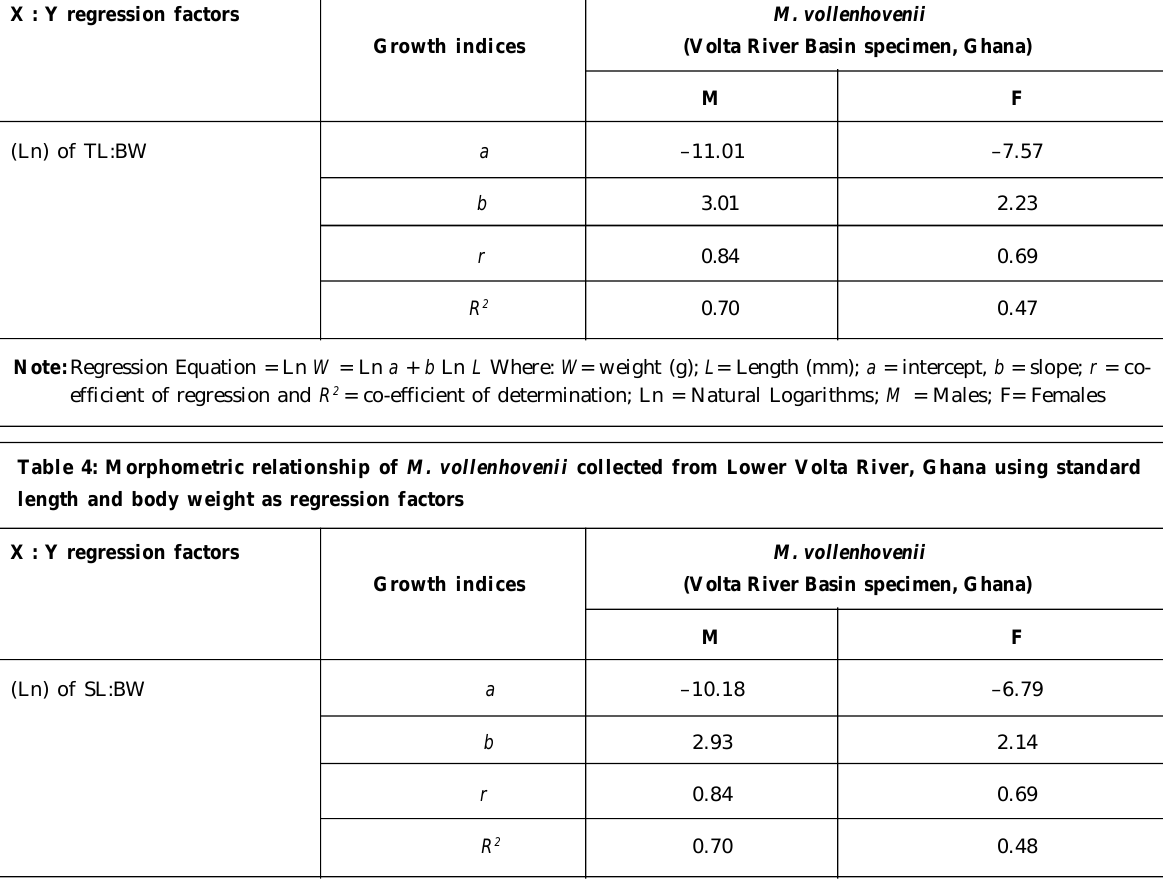
Table 3: Morphometric relationship of M. vollenhovenii collected from studied sections of Lower Volta River, Ghana using total length and body weight as regression factors X : Y regression factors M. vollenhovenii